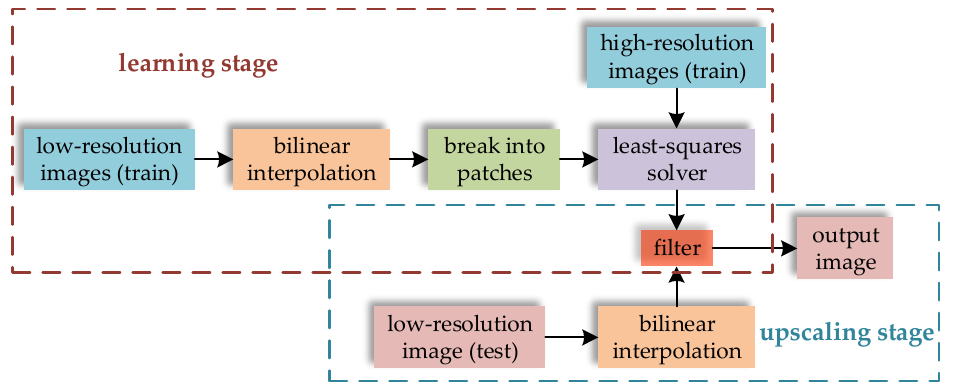
Figure 4. The process of the RAISR algorithm.